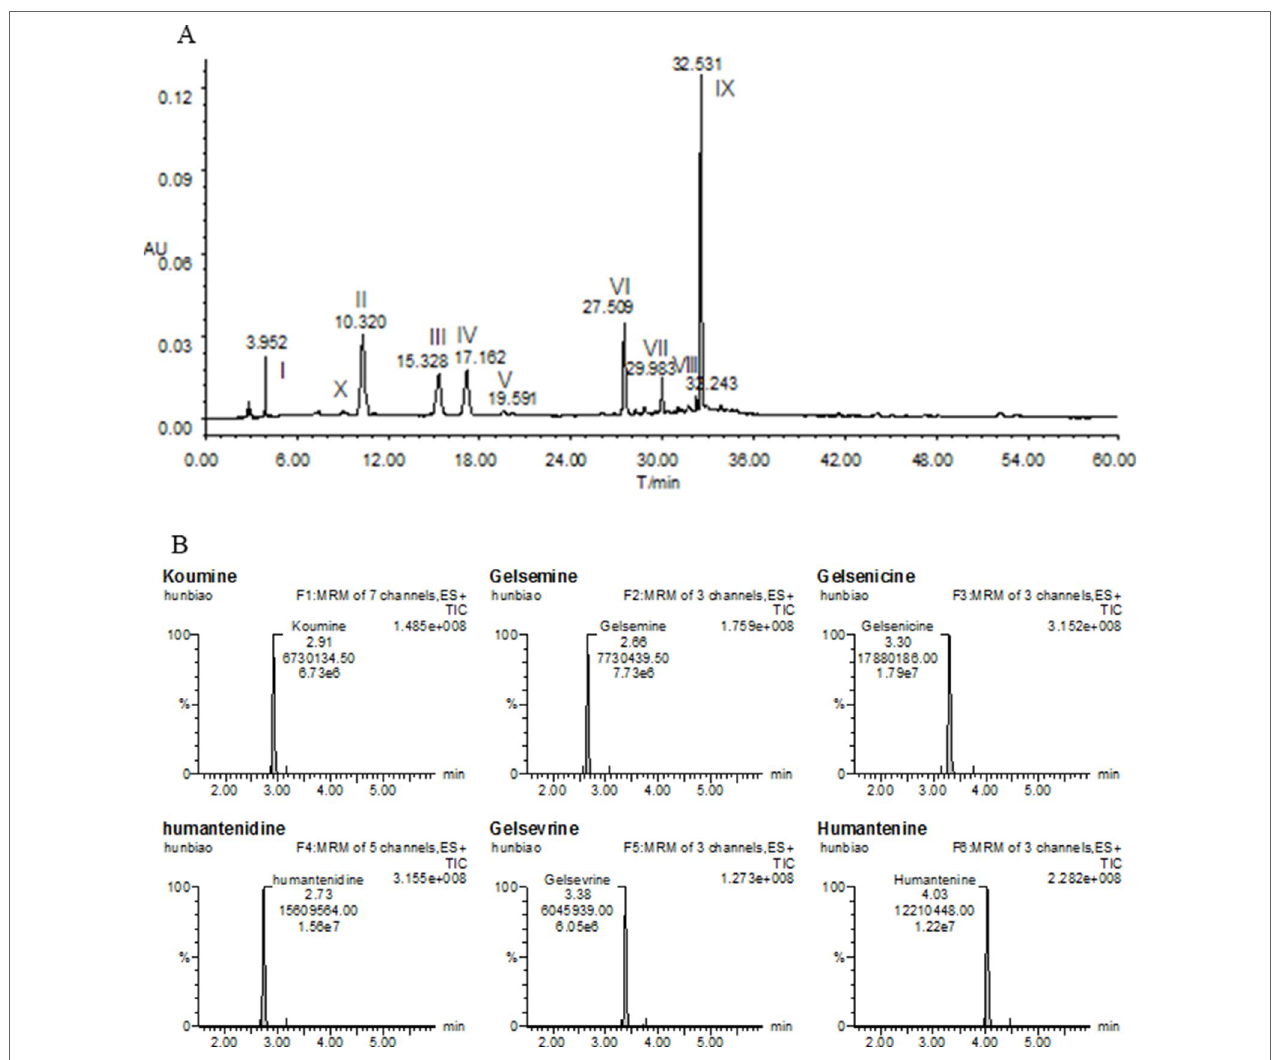
FIGURE 1 | Chemical profiles of (A) HPLC and (B) LC-MS/MS of most of the ingredients in GE extract. I, Humantenidine; II, Koumine; III, Gelsenicine; IV, Gelsevirine; VI, Humantenine; X, Gelsemine; V, VII, VIII and IX, unknown